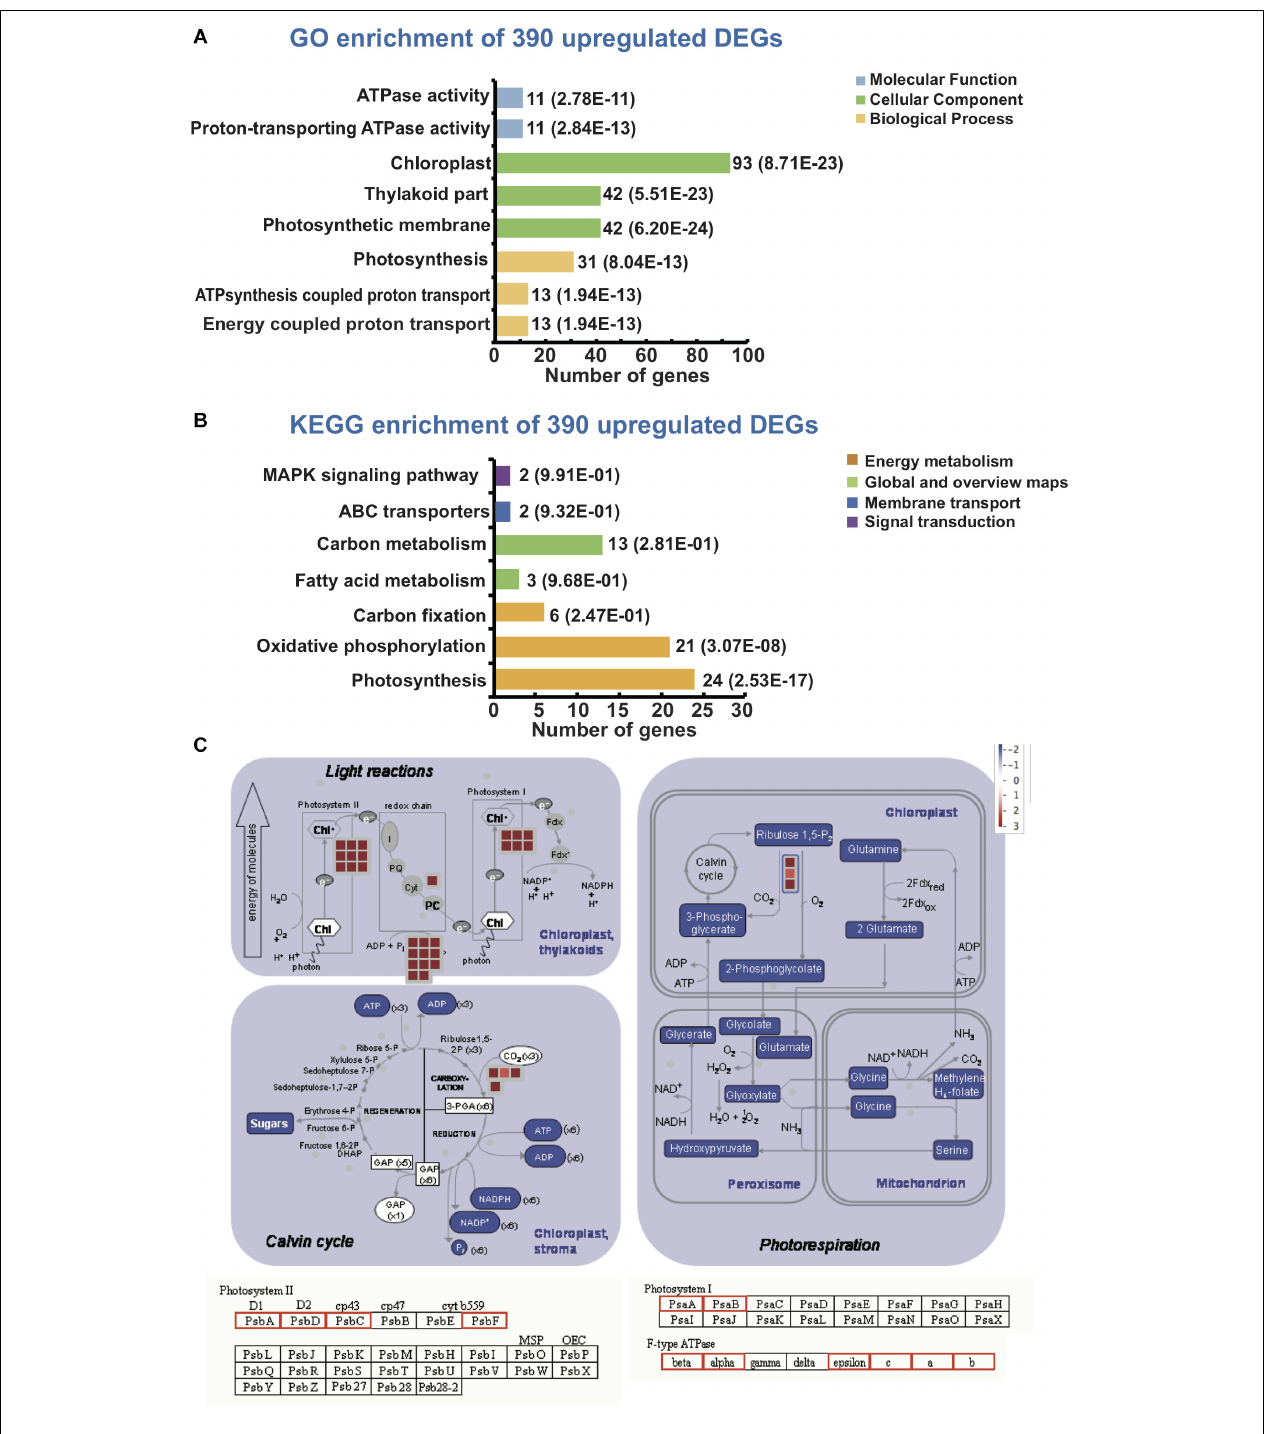
FIGURE 4 | Gene Ontology (GO) enrichment and KEGG pathway annotation of 390 upregulated pumpkin DEGs in leaves. (A) GO enrichment and (B) KEGG pathway analysis of 390 upregulated pumpkin DEGs in leaves. Colored graphs indicate the classifications of molecular function, cellular component and biological process. The numbers beside each graph represent the number of genes in the cluster and the P -value. (C) Pathway of photosynthetic metabolism for the 390 upregulated pumpkin DEGs in leaves. The boxes indicate the various metabolites encoded by the upregulated DEGs in leaves after 6 h cold treatment compared with those in the 0 h treatment. The FIGURE was sourced from “Photosynthesis” in Mapman (MapManInst-3.5.1R2).